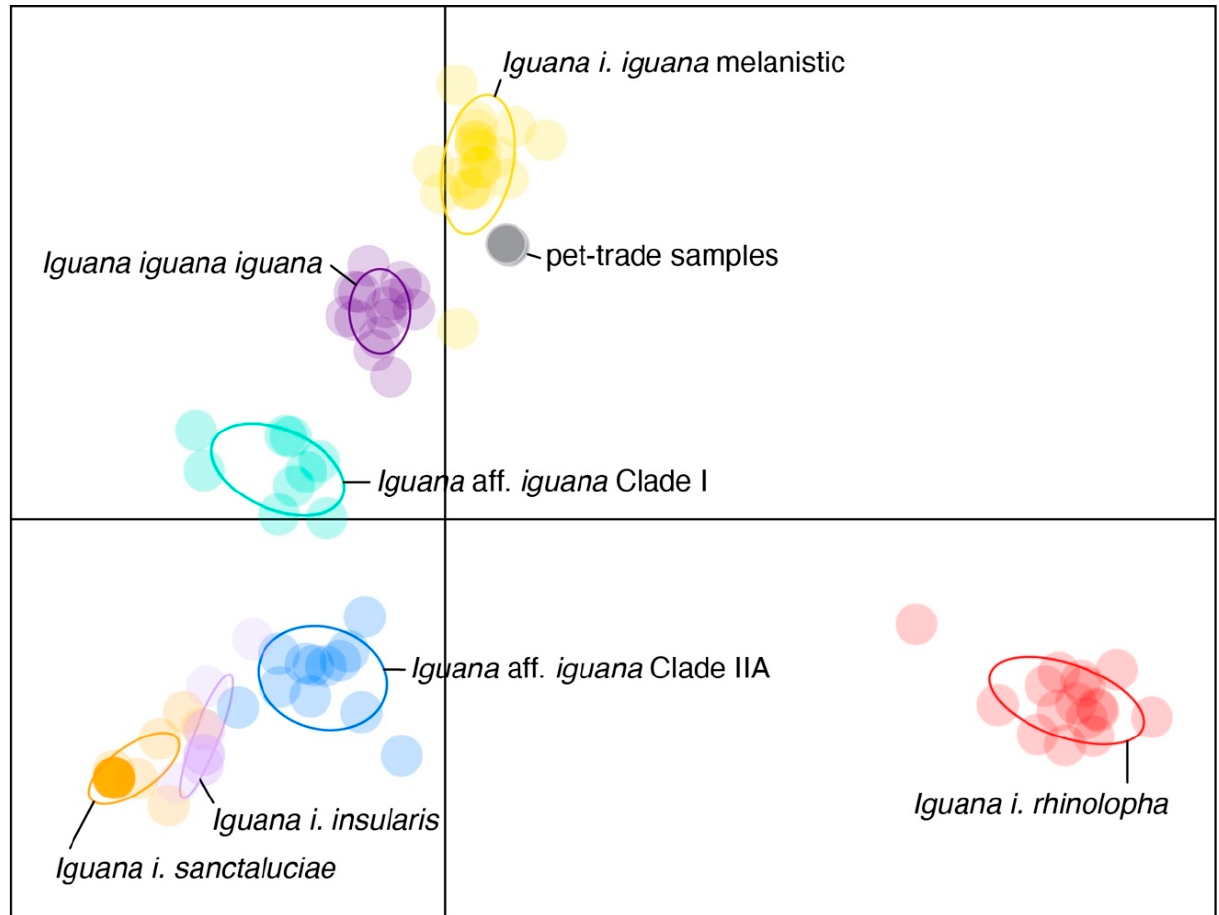
Figure 1. Discriminant principal components scatter plot generated from 17 microsatellite loci representing color-coded individuals from the IguanaBase reference database [41] and two pet-trade individuals (grey). Colored circles indicate group inertia ellipses.